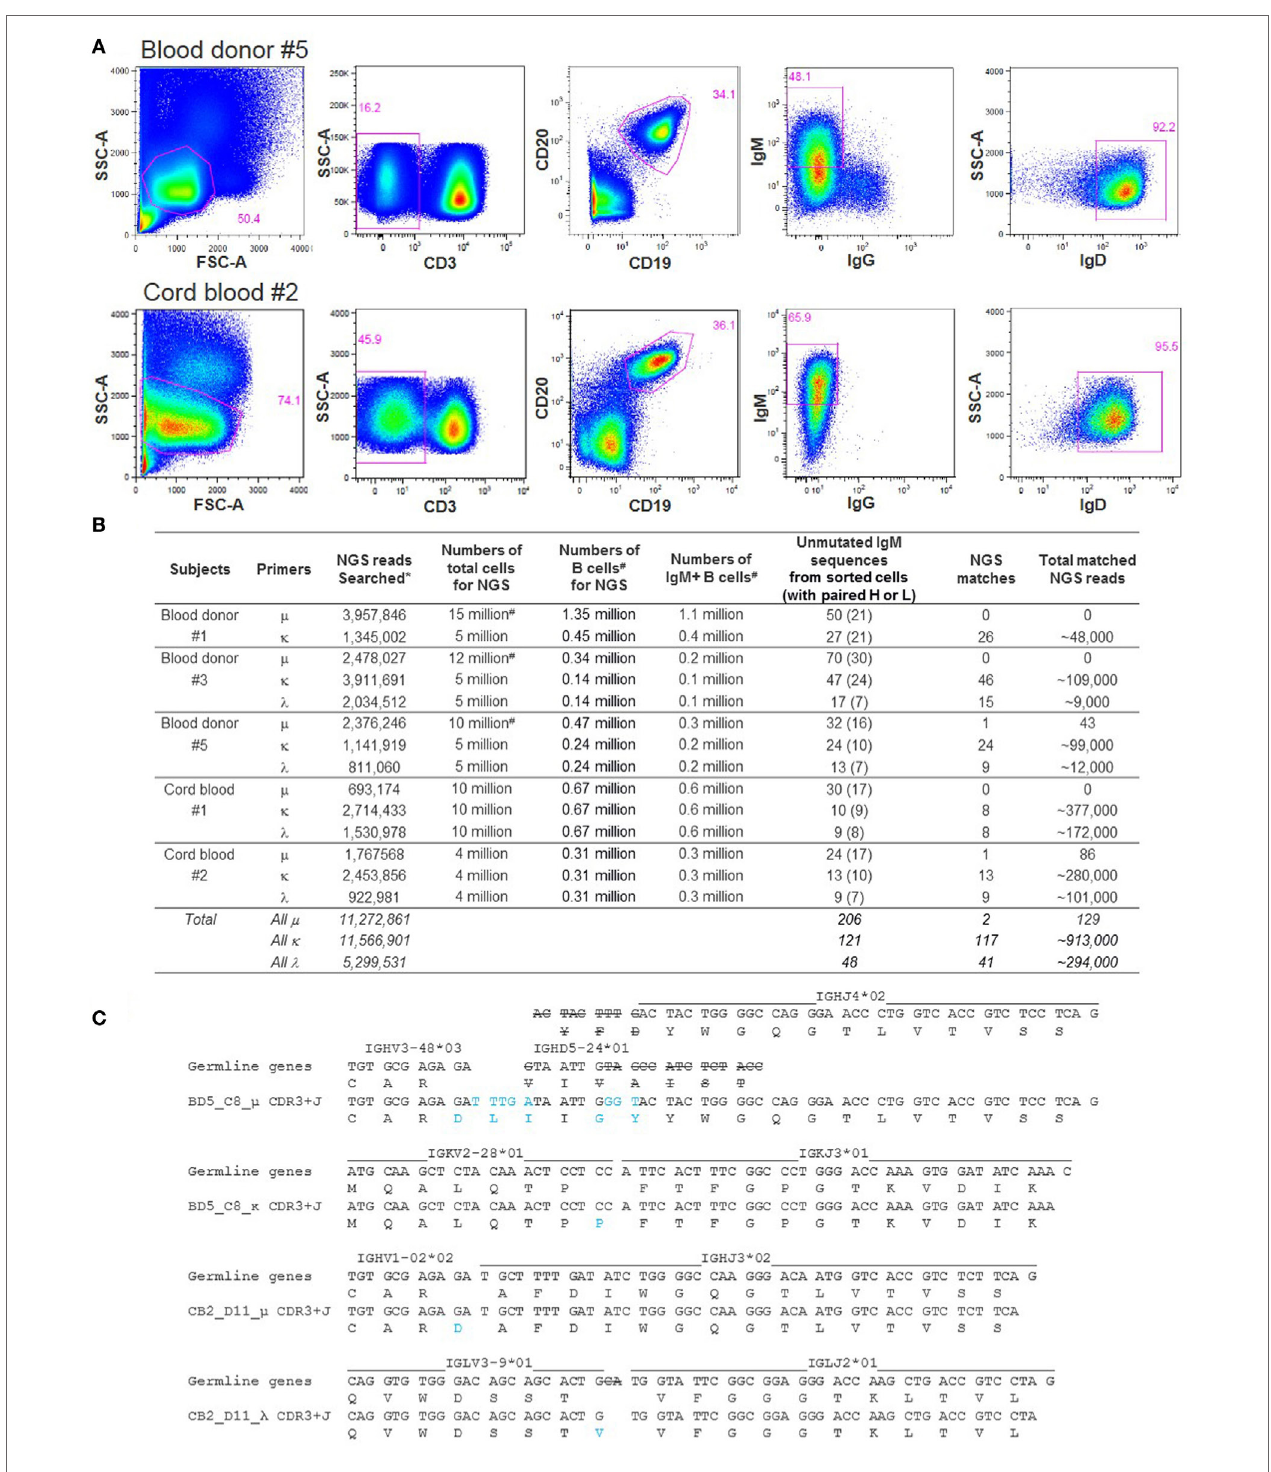
FigUre 5 | Next-generation sequencing (NGS) searches for unmutated IgM sequences obtained by single-cell sorting. (a) Representative FACS of individual IgM + IgG − IgD + B cells from blood donor #5 PBMC and from cord blood #2. About 160 cells passing through gate CD3 − CD19 + IgM + IgG − IgD + were sorted from each sample. SSC-A, side scatter area; FSC-A, forward scatter area. (B) Summary of the NGS searches for unmutated IgM sequences obtained by single-cell sorting. Symbol * notes that the NGS searches used the final processed reads and thus match the number of final reads in Table 1 . Symbol # notes that the μ reads were combined from two to three sequencing runs and that the B cell and IgM + cell numbers were back calculated from the flow cytometric data of the corresponding samples. (c) Analysis of V(D)J rearrangement and junction of the two unmutated IgM sequences identified both by single B cell sorting and NGS. Strikeouts indicate tentative exonuclease activity, and blue font indicates tentative junction